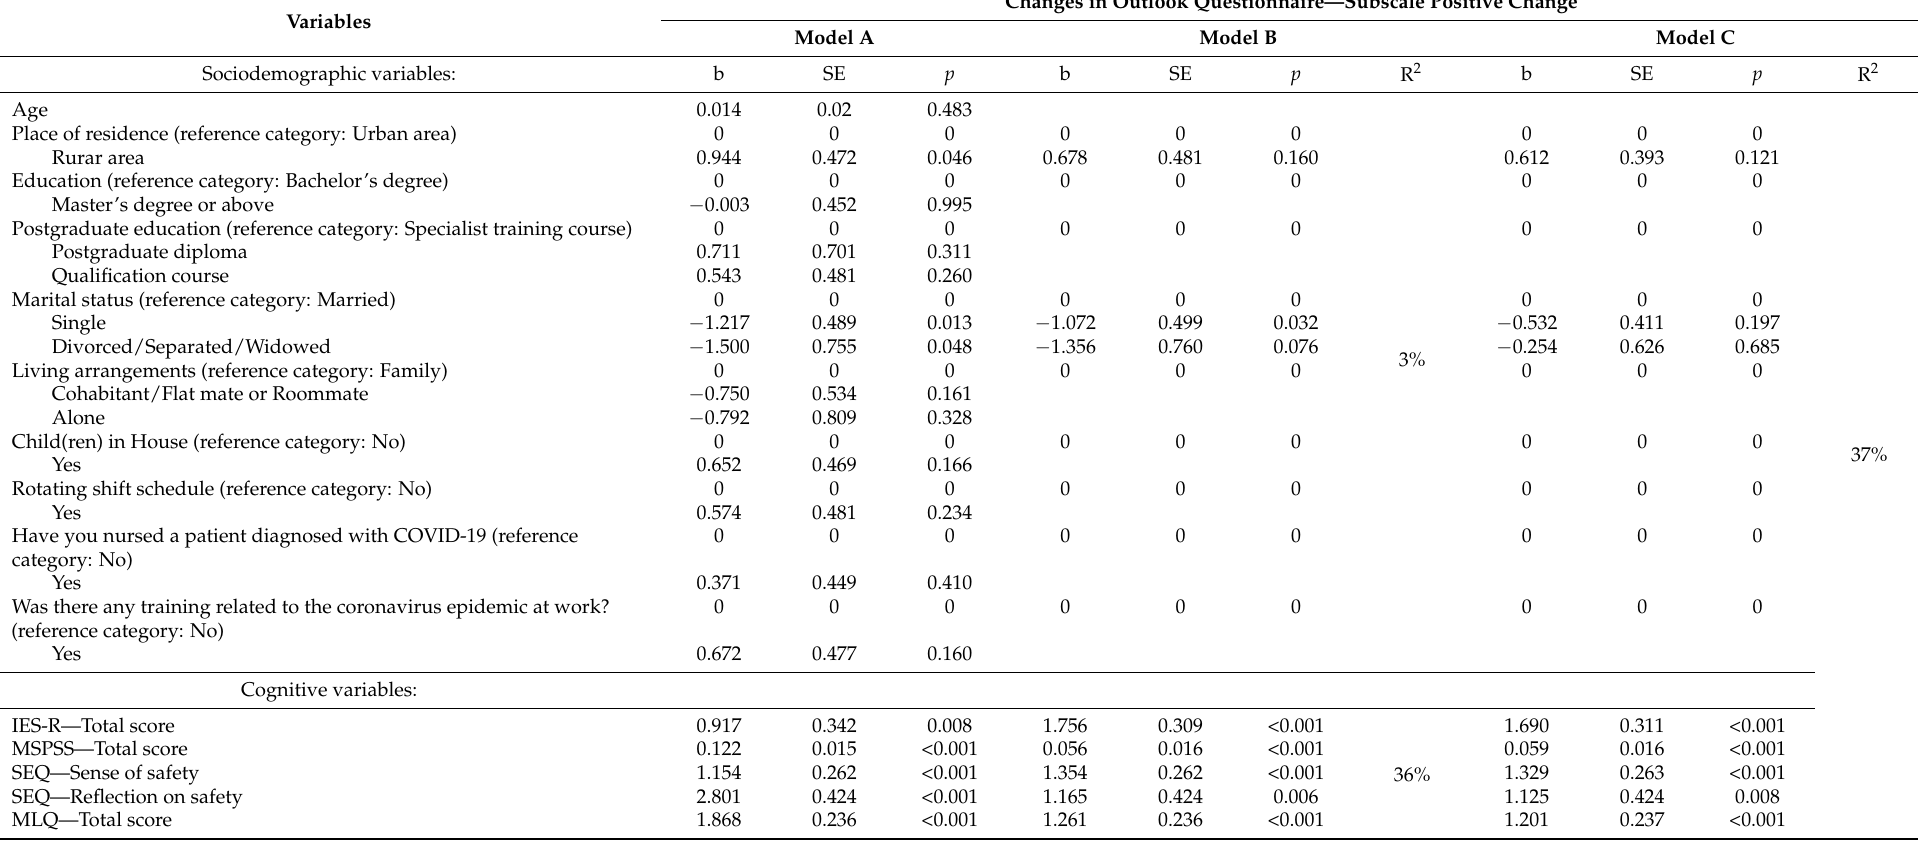
Table 4. Relationship between the positive outlook of the COVID-19 pandemic and selected sociodemographic and cognitive variables. Changes in Outlook Questionnaire—Subscale Positive Change Variables Model A Model B Model